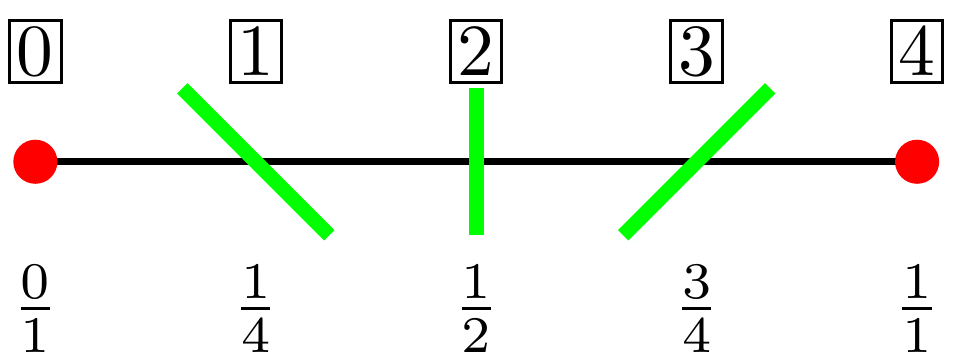
Figure 5. Intersection as fraction (multiple intersections on one